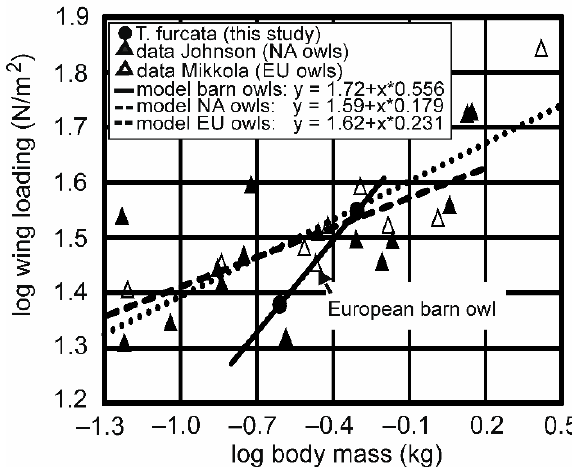
Figure 4. Comparison of wing-loading data. The data of the other owl species were taken from [14,29] (for numbers, see Table S2). Note that the relation between wing loading and body mass exhibits a much lower slope if all owl species are considered than when only the barn owls are taken into account.